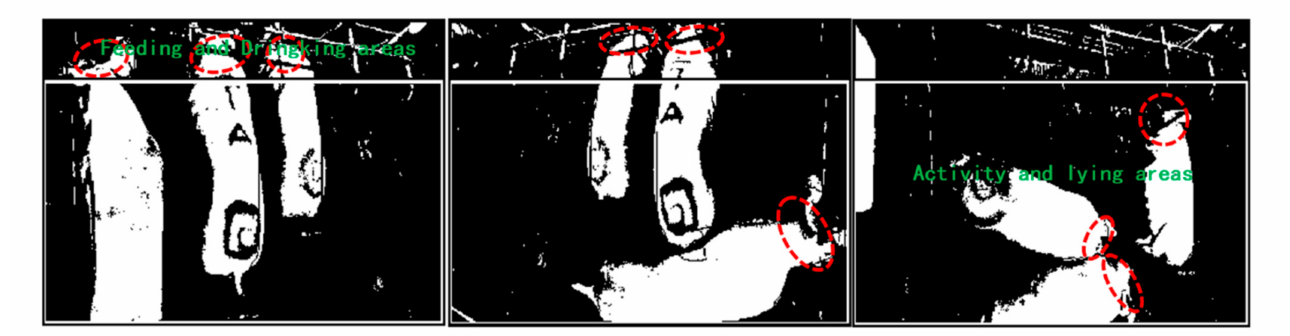
Figure 13. Binary grayscale image of sows with different behaviors and